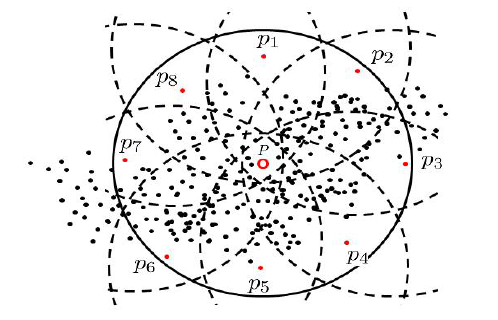
Figure 2. Cluster extension schematic of core